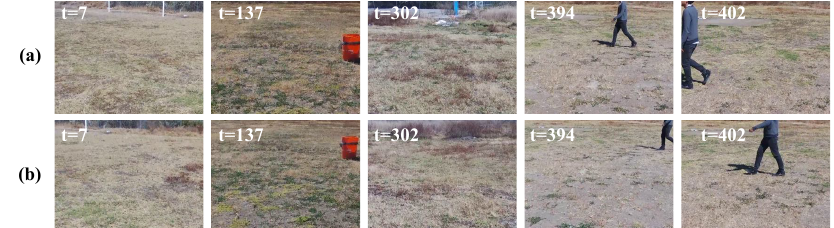
Figure 12. Sample image frames labeled as normal images by the evolved SECoS detector in the inspection phase: ( a ) sample image frames used to learn the model of the environment, and ( b ) sample images detected as normal images in the inspection